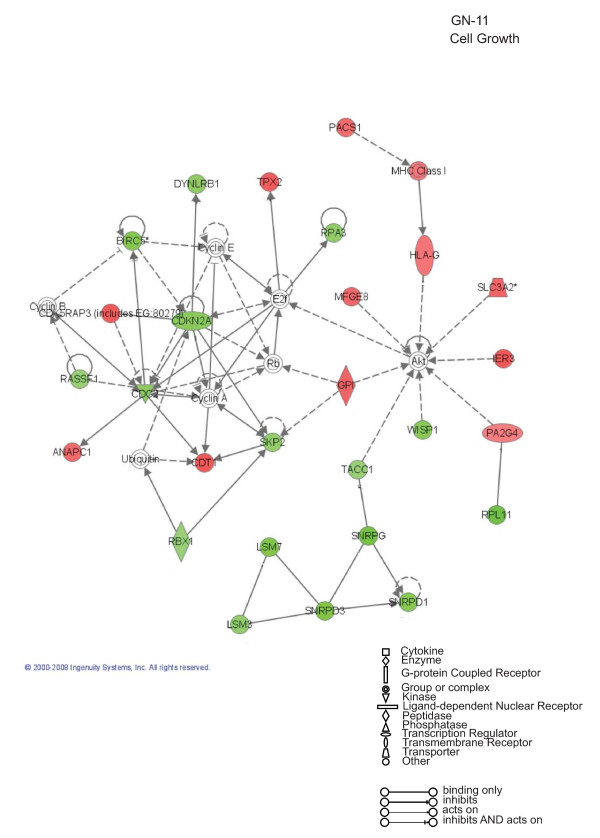
Cell Growth: Ingenuity Pathway Analysis for GN-11 neurons. Specific functional networks of the newly identified AP-2α-regulated genes were obtained using Ingenuity Pathway Analysis systems and "cell growth" is one of the two main networks found. Gene products are represented as nodes and biological relationships between two nodes as a line. Continuous lines indicate direct interactions, while dashed lines represent indirect connections. Shapes of nodes symbolize functional classes of gene products (see the figure legend). The green and red symbols represent down- and up-regulations, respectively, while the white symbols indicate genes absent in the dataset but related with the dataset genes.